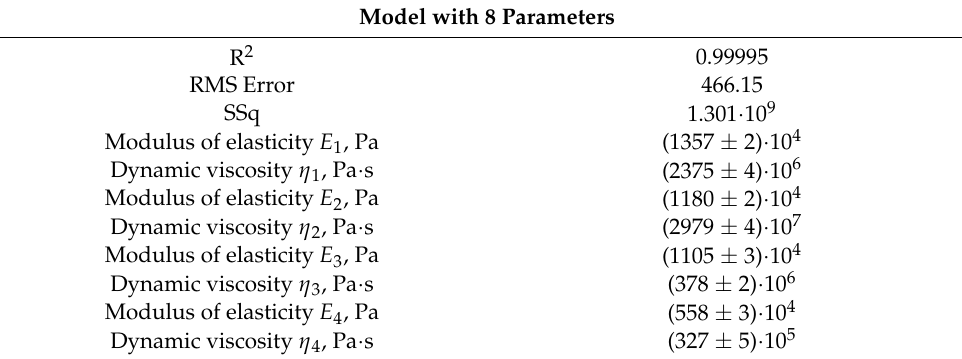
Table 4. Values of parameters in a generalized Maxwell model with eight parameters for unaged asphalt binder containing 4.5% SBS.